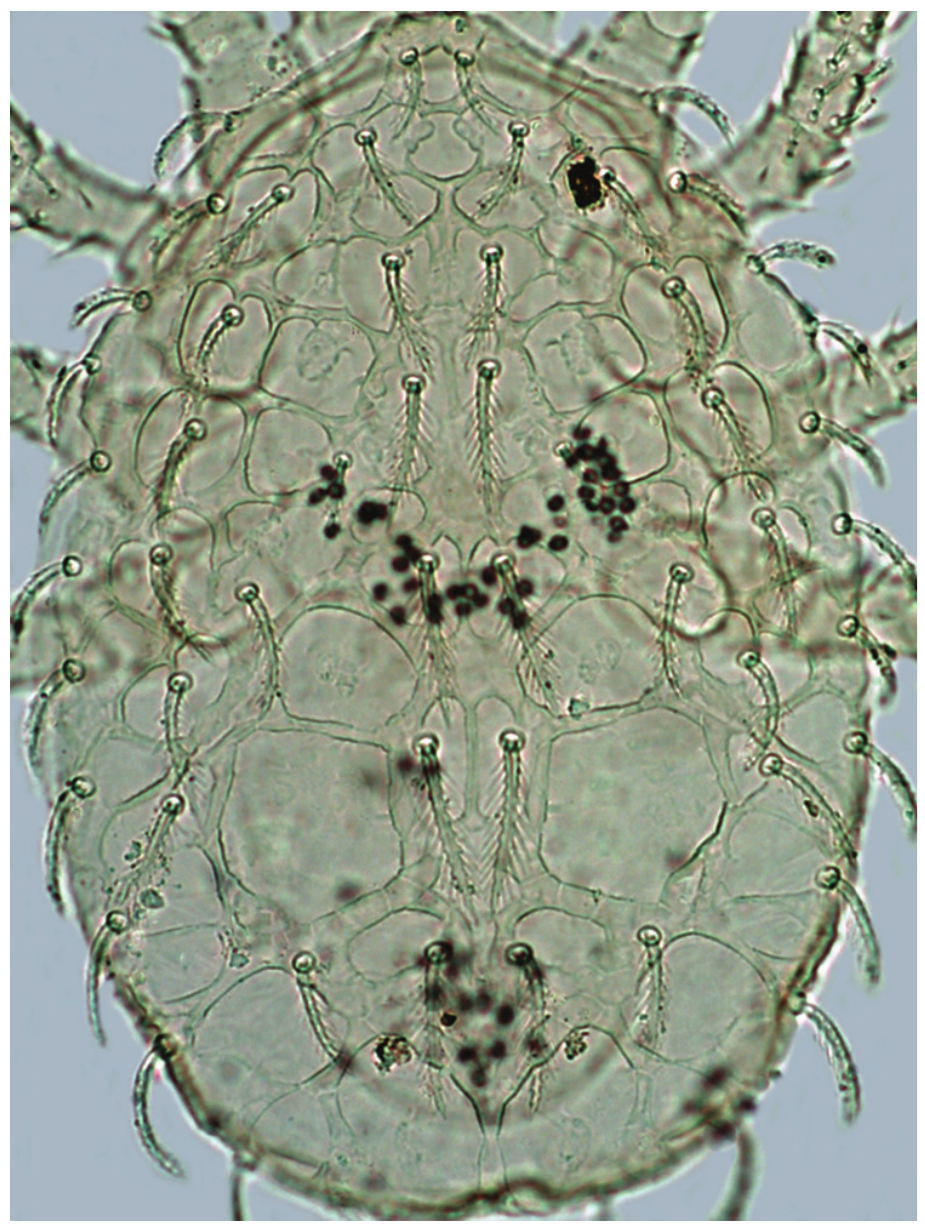
Plate 73. Sinoseius lobatus , female, dorsal idiosoma (pressed